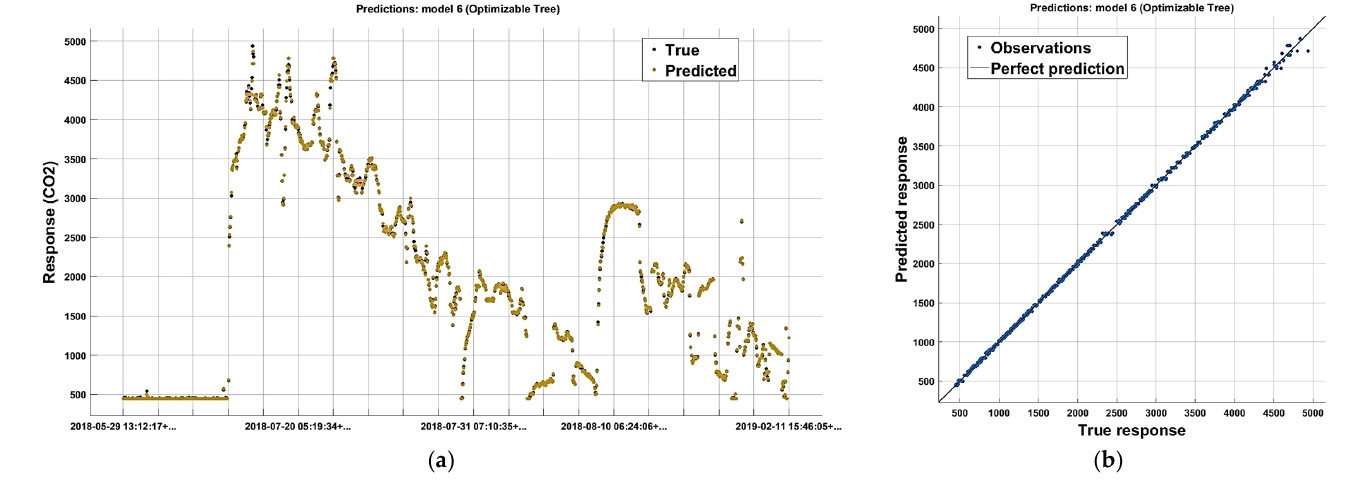
Figure 13. SCI based Iterative Optimization of the OBRM2 for CO2: ( a ) Iterative Optimization of OBRM1 to OBRM2 and ( b ) OBRM3 Prediction Response.